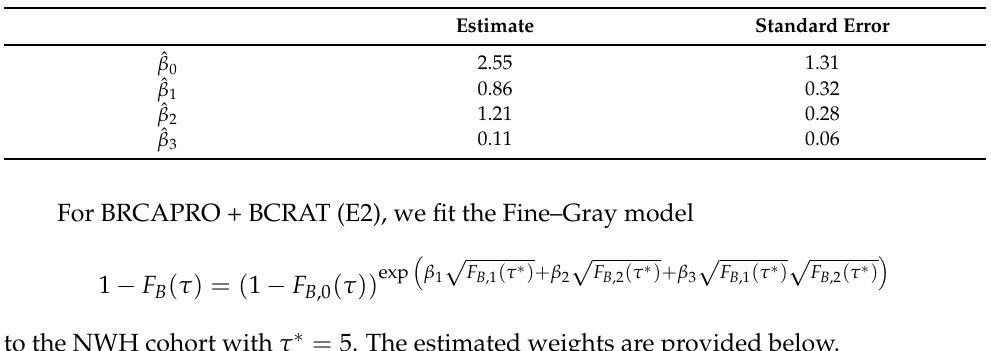
Table A2. Coefficient estimates for BRCAPRO + BCRAT (E).